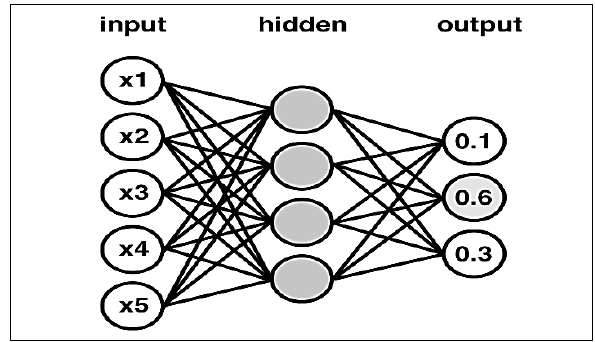
Figure 10: Illustration of the Artificial Neural Networks